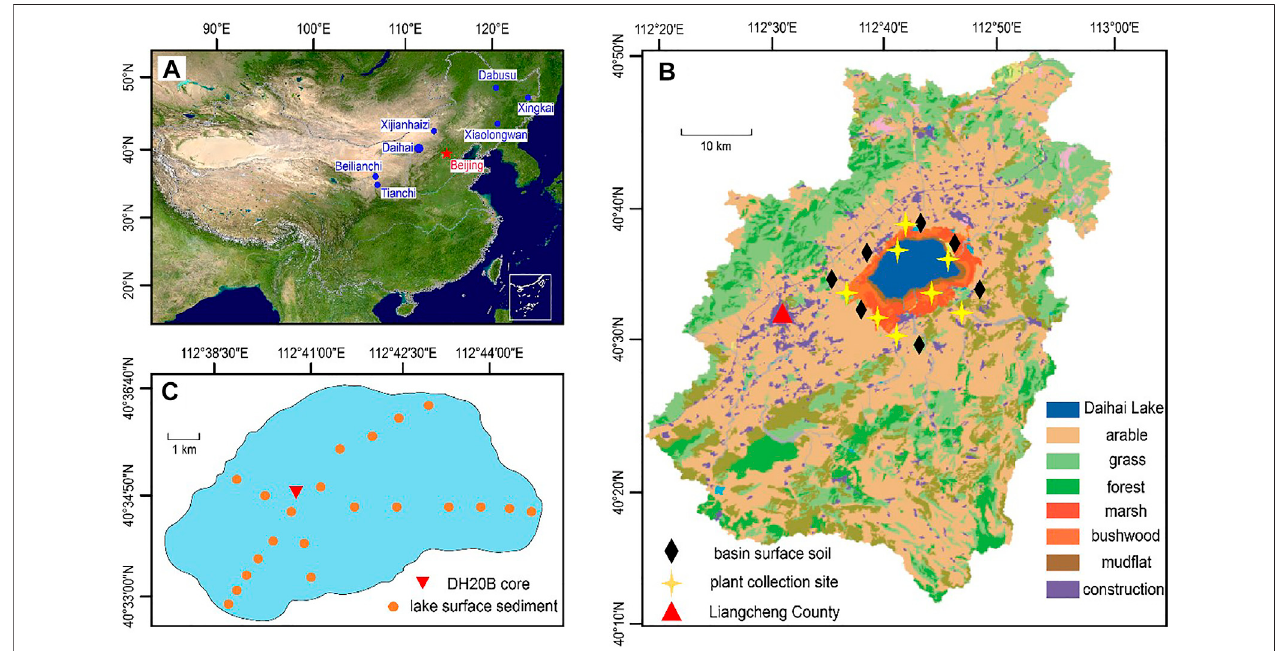
FIGURE1| Studysiteandsamplinglocations. (A) LocationofDaihaiLakeandotherlakescitedinthisstudy. (B) MapoflanduseintheDaihaiLakebasin,modi fi ed from Liang et al. (2021). The diamonds and crosses indicate the basin soil and plant leaf sampling sites, respectively. (C) Daihai Lake area and sampling sites of DH20B and lake surface sediment.